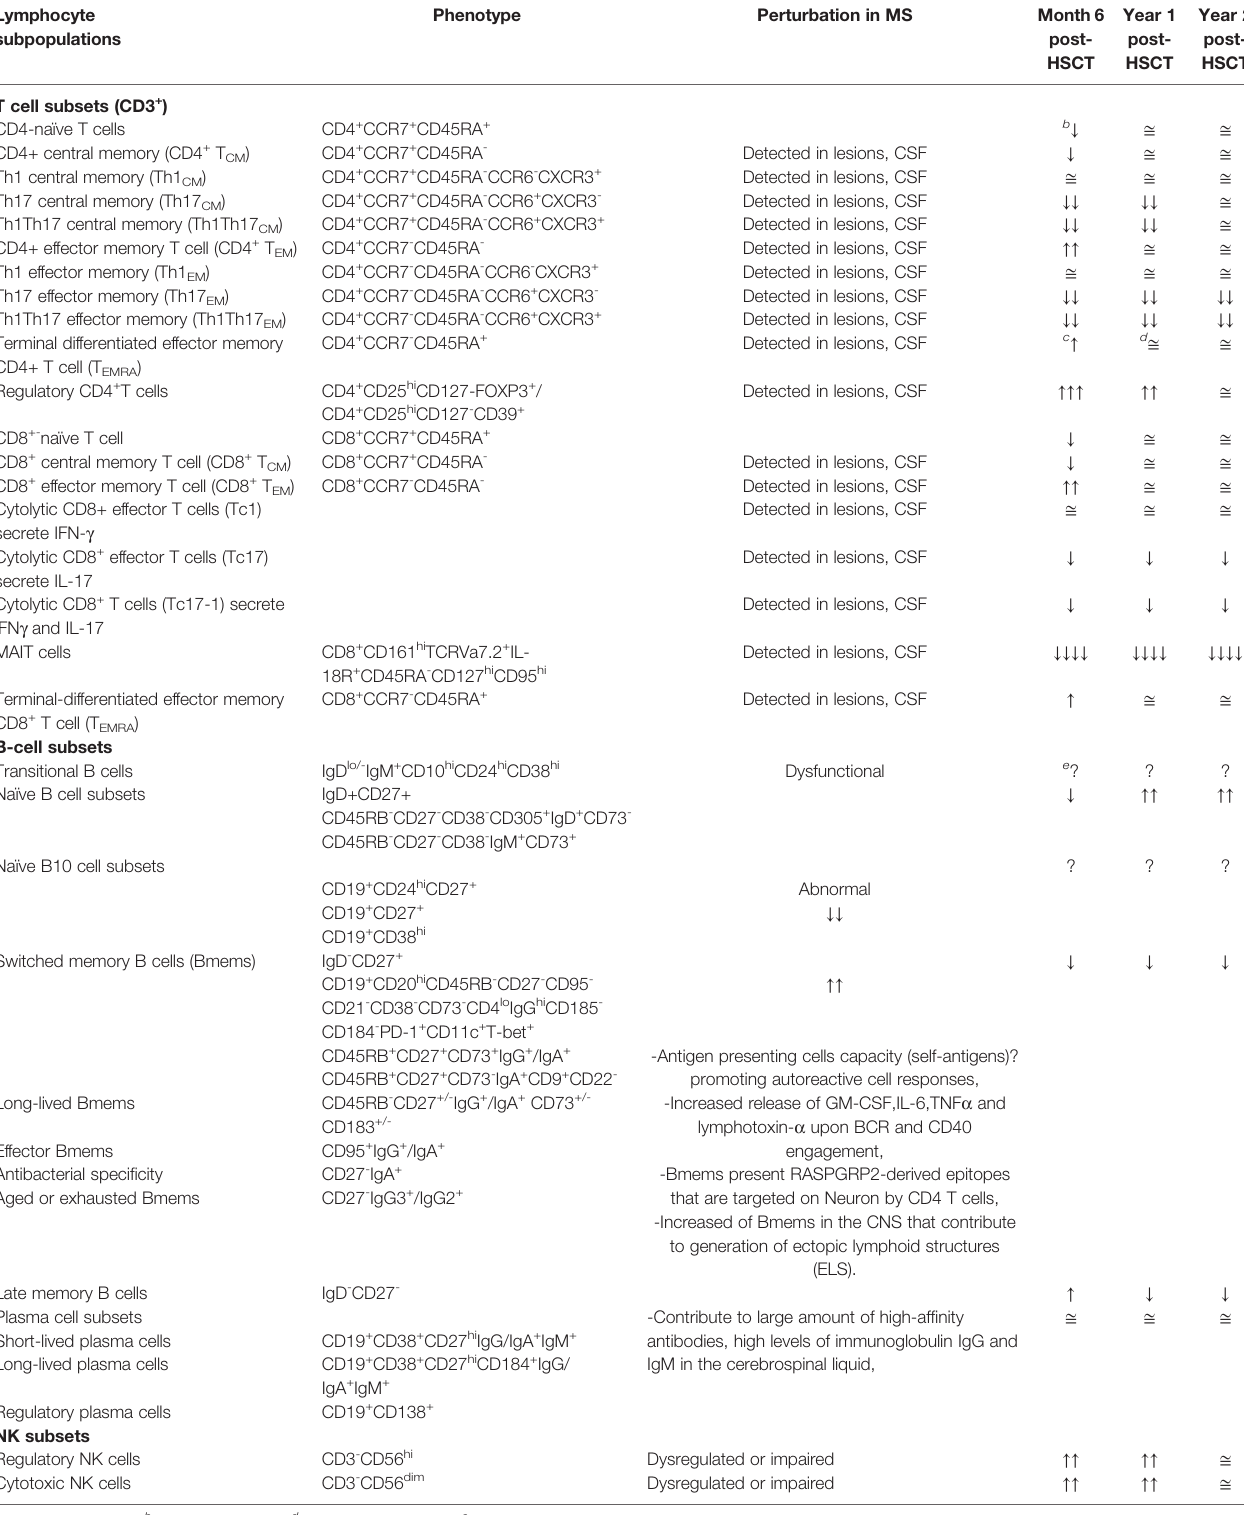
TABLE 2 | Phenotype of human B, T, and natural killer (NK) cell subsets in the periphery. Lymphocyte